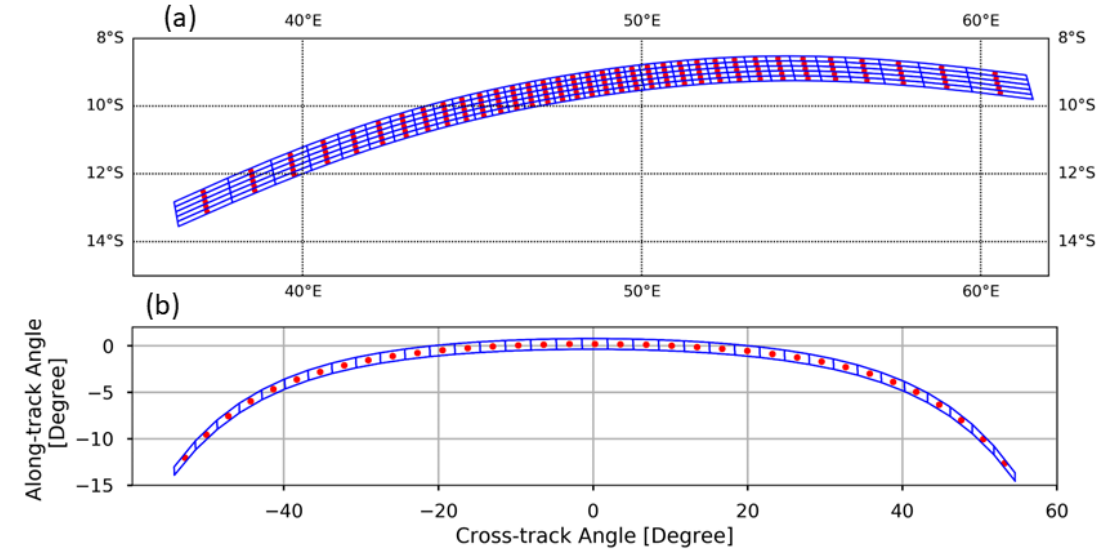
Figure 3. Example of OMPS-NM macropixel FOV shapes projected ( a ) on the Earth Surface, shown as longitude and latitude and ( b ) on the S/C coordinate expressed in the along-track and in-track angles (indicated by the bluelines). The red dots point to the FOV center. The FOVs on the Earth’s location in five scanlines return to identical locations on the S/C coordinate after the inverse geolocation computation.